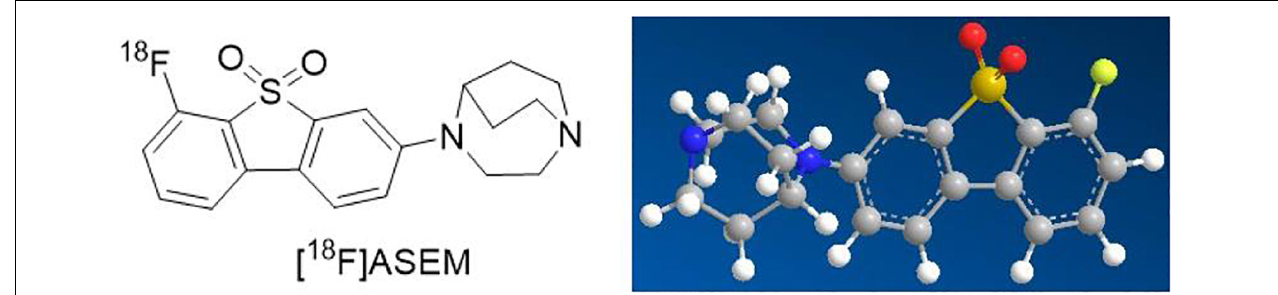
FIGURE 1 | The chemical structure and three-dimensional structure of 18 F-ASEM.